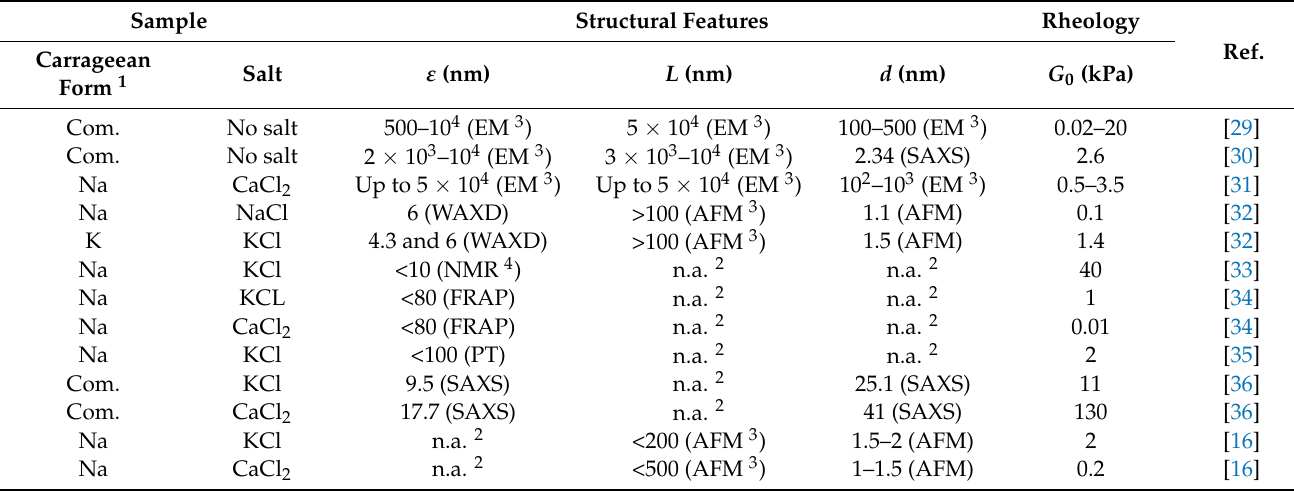
Table 1. Structural and elastic properties of Kappa gels prepared with salt conditions and carrageenan samples specified in the first column “System”. Mesh size ε , length L and diameter d of strands were obtained from electronic microscopy (EM), fluorescence recovery after photobleaching (FRAP), particles tracking (PT), atomic force microscopy (AFM), nuclear magnetic resonance (NMR), small angle X-ray scattering (SAXS) or wide angle X-ray scattering (WAXD). Column G 0 reports the range of gel linear shear storage modulus G 0 measured at temperatures between 10 and 25 ◦ C. The last column lists the referenced literature for the corresponding row.